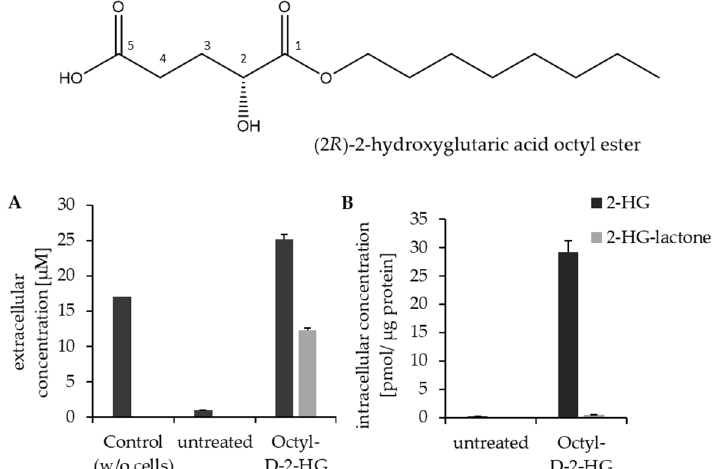
Figure 7. Parental HCT116 cells were treated with 100 µM octyl-D-2-HG and compared to untreated cells. ( A ) 2-HG and 2-HG-lactone levels in cell culture supernatant and ( B ) intracellular levels (n = 3). This experiment showed that the hydrolysis of octyl-D-2-HG already takes place in a medium releasing free 2-HG, but lactone formation is only found in the presence of cells. 2-HG, but no 2-HG-lactone, was detected in blank medium incubated with octyl-D-2-HG but without cells (left bar). The percentage of 2-HG-lactone from the sum of 2-HG and lactone was higher in the medium than in the cell extracts. Intracellular 2-HG-lactone concentration was close to LLOQ. Octyl-D-2-HG treatment was also performed with nine additional WT- IDH1/2 cell lines of different origins (Figure S3). Interestingly, upon octyl-D-2-HG treatment, all cell lines were capable of 2-HG lactonization, with most of the lactone found extracellularly.